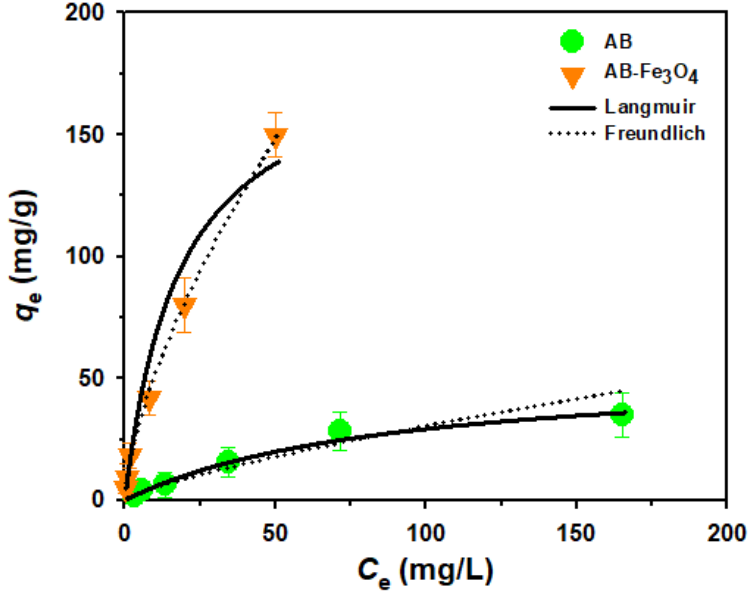
Figure 9. Equilibrium isotherms for adsorption of TeCP on AB and AB-Fe 3 O 4 at pH 3.5 ( V = 30 mL, adsorbent mass 30 mg, agitation speed = 300 rpm, temperature = 25 ± 1 ◦ C, and reaction time = 240 min).